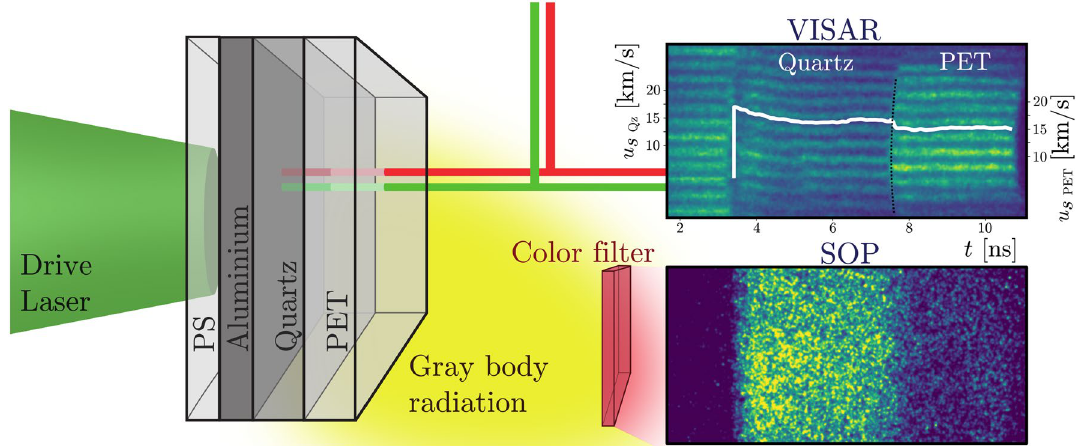
Figure 5. Experimental setup applied for the Hugoniot measurements. VISAR and SOP were used to diagnose the conditions inside the shock-compressed layered sample. The data shown corresponds to a drive laser energy of 400 J. Upper insert: Shock velocity extracted from VISAR fringe-shifts over time. The dashed line denotes the position where the material (and therefore the index of refraction) changes, resulting in a jump in the scale.